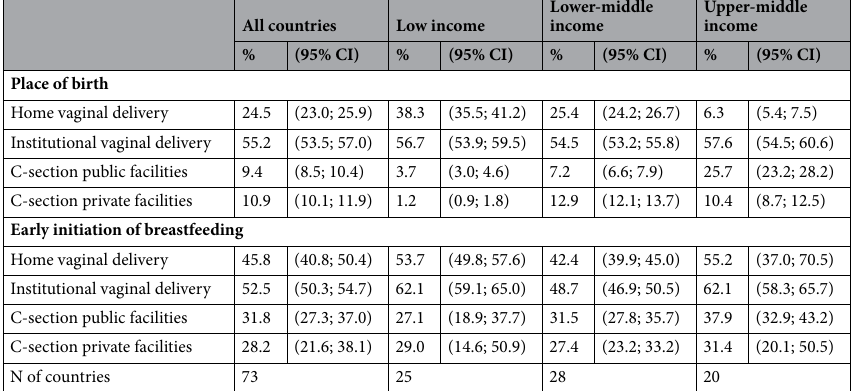
Table 1. Weighed a mean prevalence of place of birth and early initiation of breastfeeding for 73 countries with available household surveys b from 2010–2019. a Weighed for national population of women of reproductive age (15–49 years); source: World Bank, 2020. b Multiple Indicator Cluster Survey, Demographic Health Survey and National Health and Nutrition Survey (Ecuador). C-section cesarean section; CI confidence